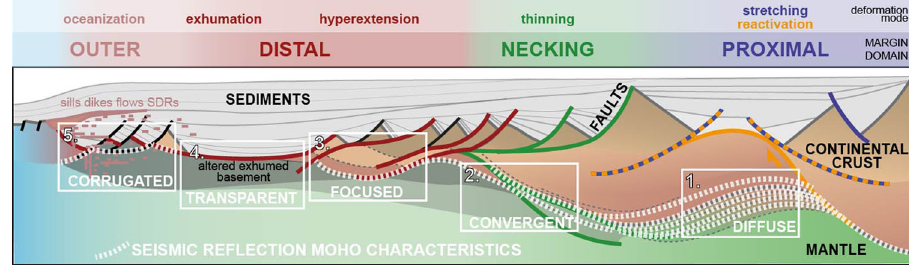
Fig. 4 The different seismic re fl ection Mohos identi fi ed in the different margin structural domains. Schematic geosection summarizing the main structural characteristics of a standard rifted margin. Modi fi ed after Peron-Pinvidic and Osmundsen 54 . The thick dashed white lines illustrate the different seismic re fl ection Mohos identi fi ed in this study, summarizing their main characteristics with keywords: diffuse in the proximal domain, convergent in the necking domain, focused in the hyperextension subdomain, transparent in the exhumation subdomain, and corrugated in the outer domain. The faults are color-coded based on their assumed tectonic evolution related to the deformation phases and margin